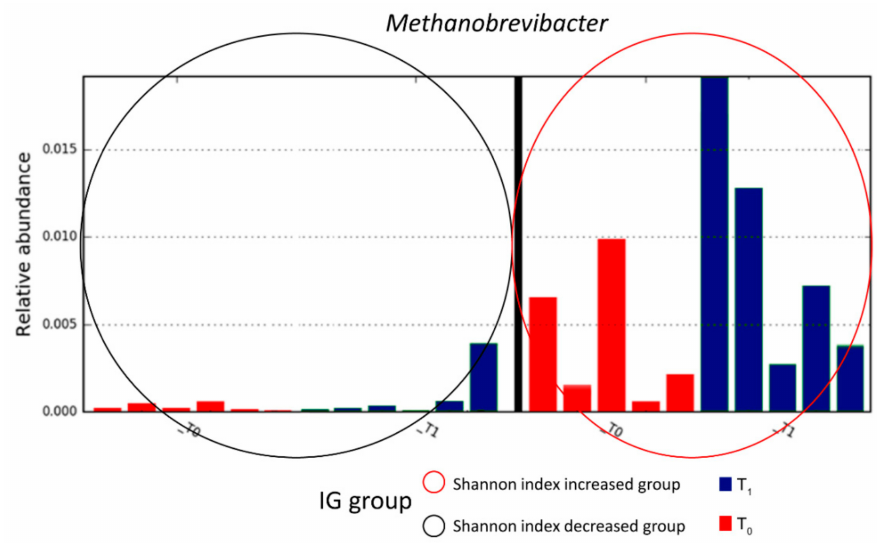
Figure 5. Linear discriminant analysis (LDA) effect size (LEfSe) analysis. Analysis was performed by grouping IG patients on the basis of the Shannon index trend. The red oval indicates the subgroup of patients in which the Shannon index was increased at T 1 , while the black oval indicates the subgroup of patients in which the Shannon index was decreased at T 1